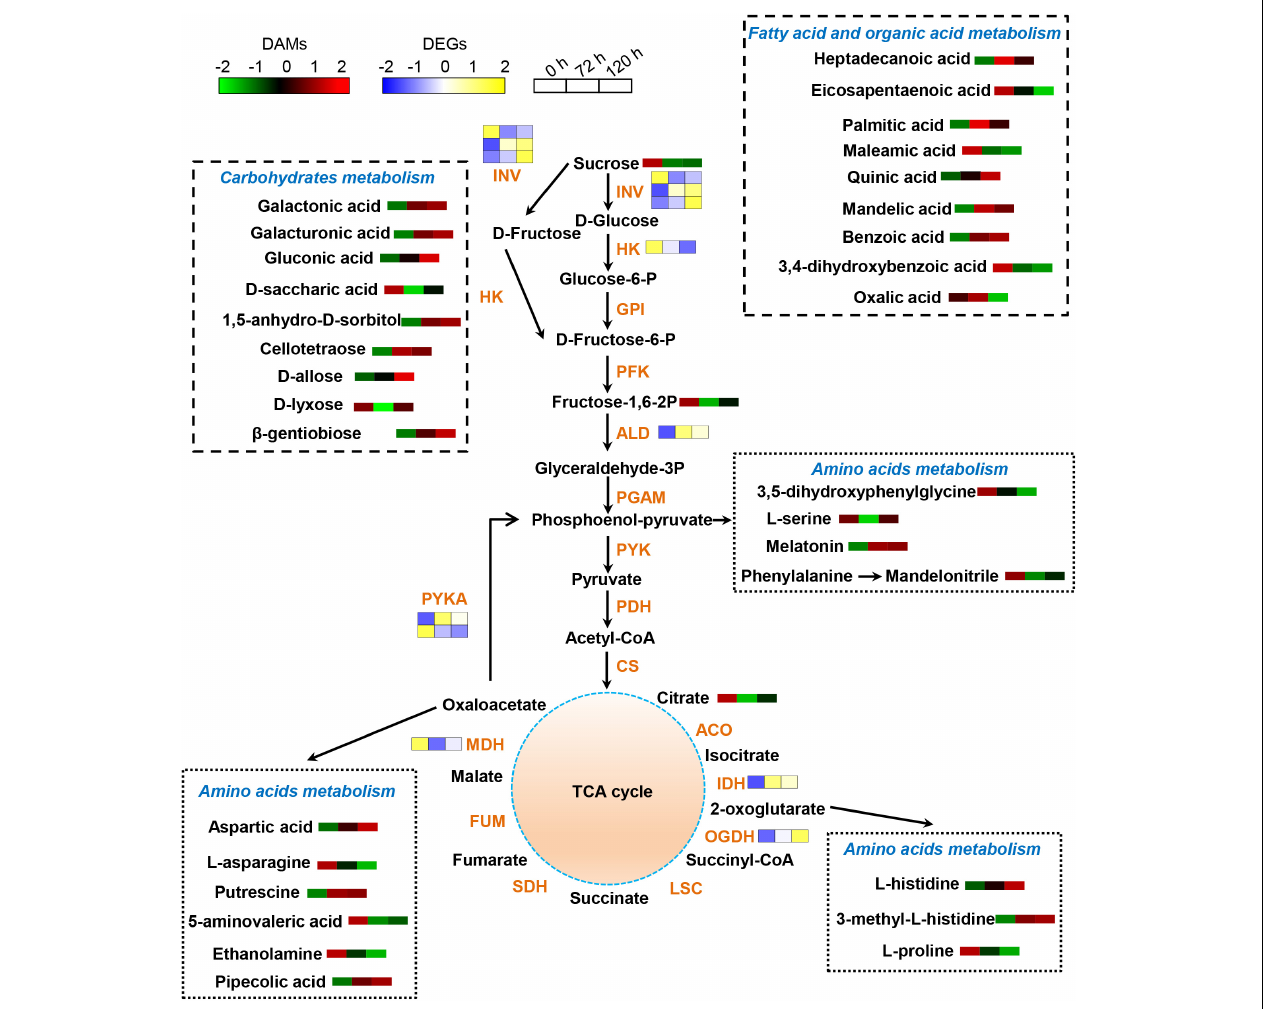
FIGURE 8 | Schematic diagram of proposed metabolic pathways in peach roots in response to BA stress. Pathway was constructed based on the KEGG database and library reference. The abundances of DAMs and DEGs are shown by the heatmap at 0, 72, and 120 h post BA treatment. The color of the heatmap changed from green to red (blue to yellow), indicating that the abundances of DAMs (DEGs) ranging from low to high. INV, invertase; HK, hexokinase; GPI, glucose-6-phosphate isomerase; PFK, 6-phosphofructokinase; ALD, fructose-bisphosphate aldolase; PGAM, 2,3-bisphosphoglycerate-dependent phosphoglycerate mutase; PYK, pyruvate kinase; PDH, pyruvate decarboxylase; CS, citrate synthase; ACO, aconitate hydratase; IDH, isocitrate dehydrogenase; OGDH, 2-oxoglutarate dehydrogenase; LSC, succinyl-coA synthetase; SDH, succinate dehydrogenase; FUM, fumarate hydratase; MDH, malate dehydrogenase; PYKA, phosphoenolpyruvate